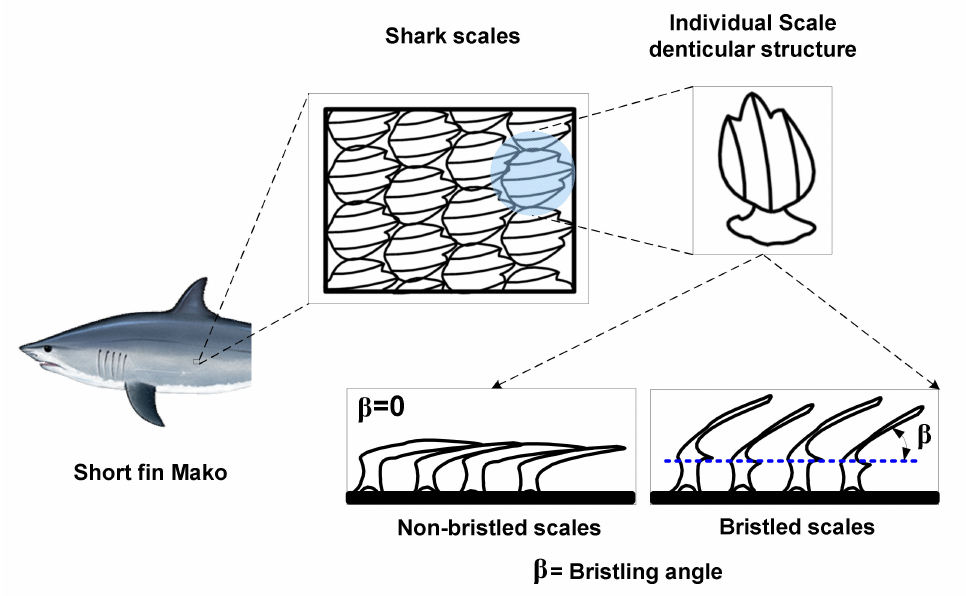
Figure 1. A schematic representation of scales on the short fin mako sharks and denticular structure of individual scales under bristled and non-bristled